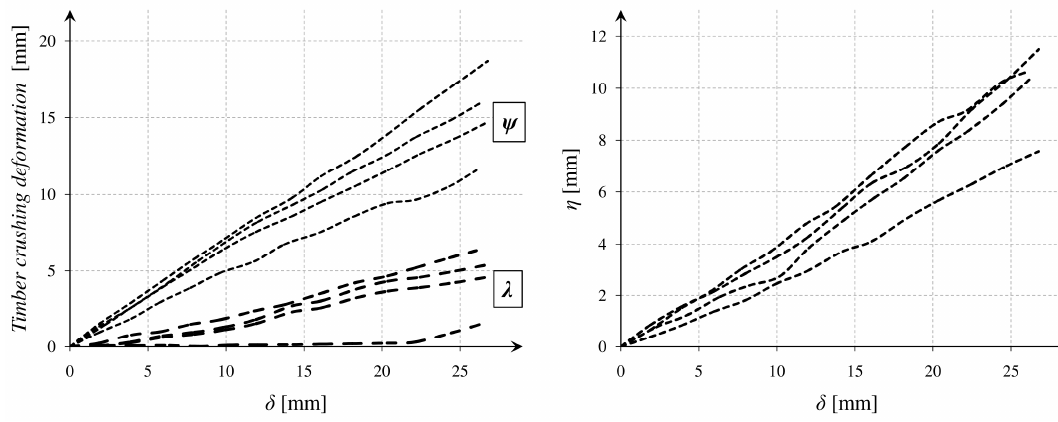
Figure 5. Experimental ψ ( δ ) and η ( δ ) relations.